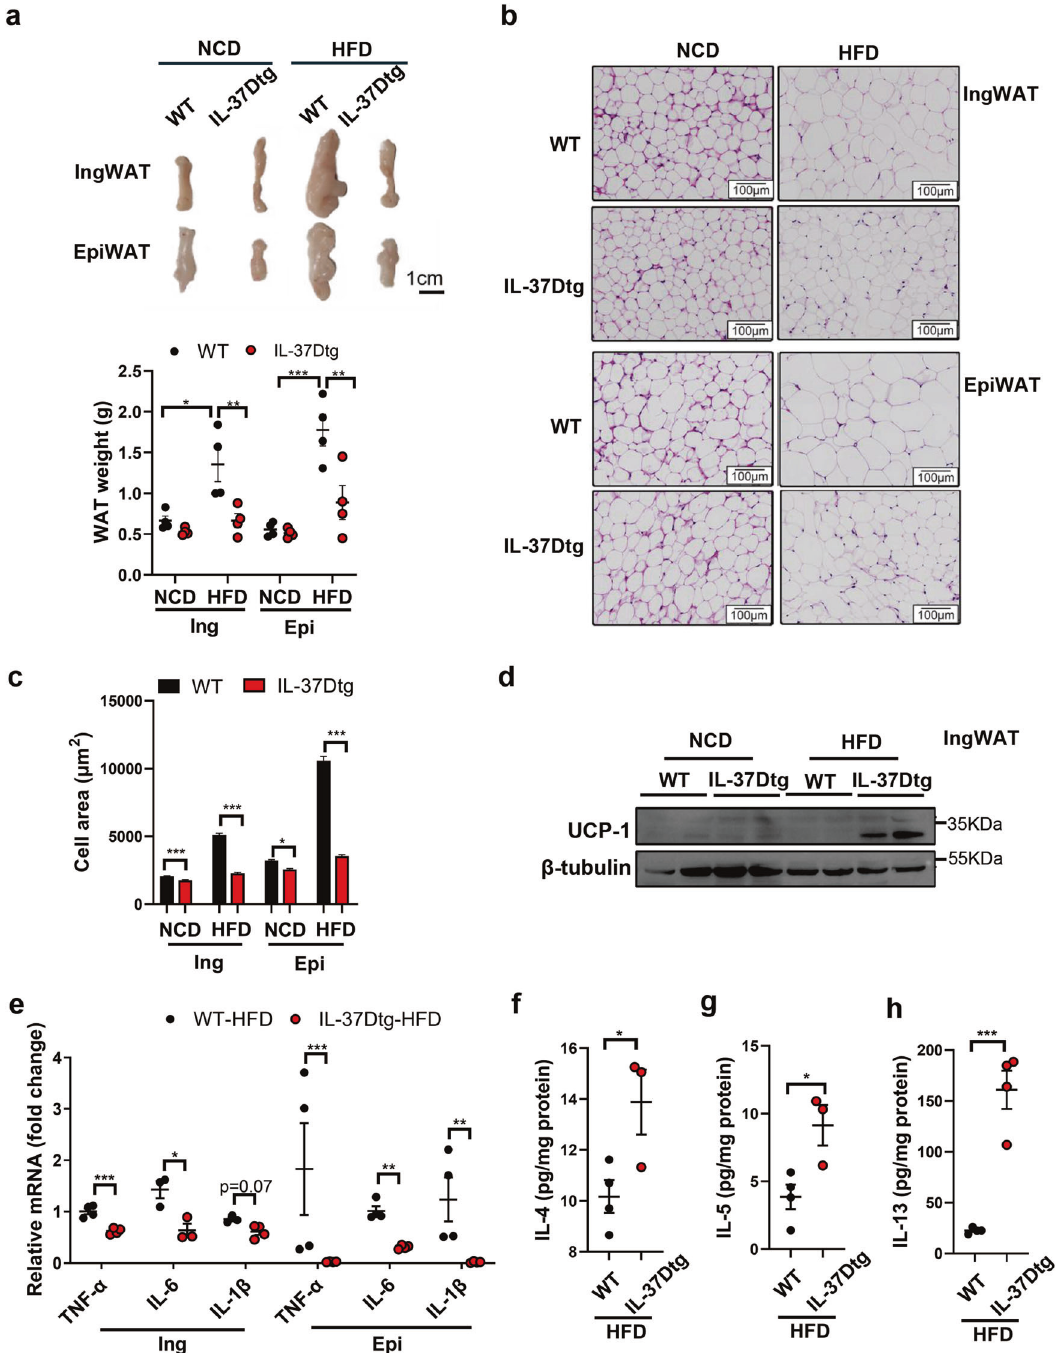
Fig. 3 IL-37D transgene promotes WAT homeostasis and beiging via upregulating type 2 cytokines in HFD-fed mice. a – d IL-37Dtg and WT mice were fed on 18 weeks of HFD ( n = 4 per group). The morphology and weight ( a ) of inguinal and epidydimal WAT (IngWAT, EpiWAT) are shown. WAT sections were stained with H&E ( b ) and adipocyte sizes were measured using Image-J ( c ). The protein levels of UCP-1 ( d ) were detected by western blot. e – h IL-37Dtg and WT mice fed on 23 weeks of HFD ( n = 4 per group). The mRNA levels of IL-6, IL-1 β , and TNF- α in WAT explants were determined by qPCR ( e ). The secretion levels of IL-4 ( f ) IL-5 ( g ) and IL-13 ( h ) from inguinal WAT explants were detected by ELISA. Data represent mean ± SEM. * p < 0.05, ** p < 0.01, *** p < 0.001, determined by two-way ANOVA ( a , c ) or student ’ s t test ( e – h